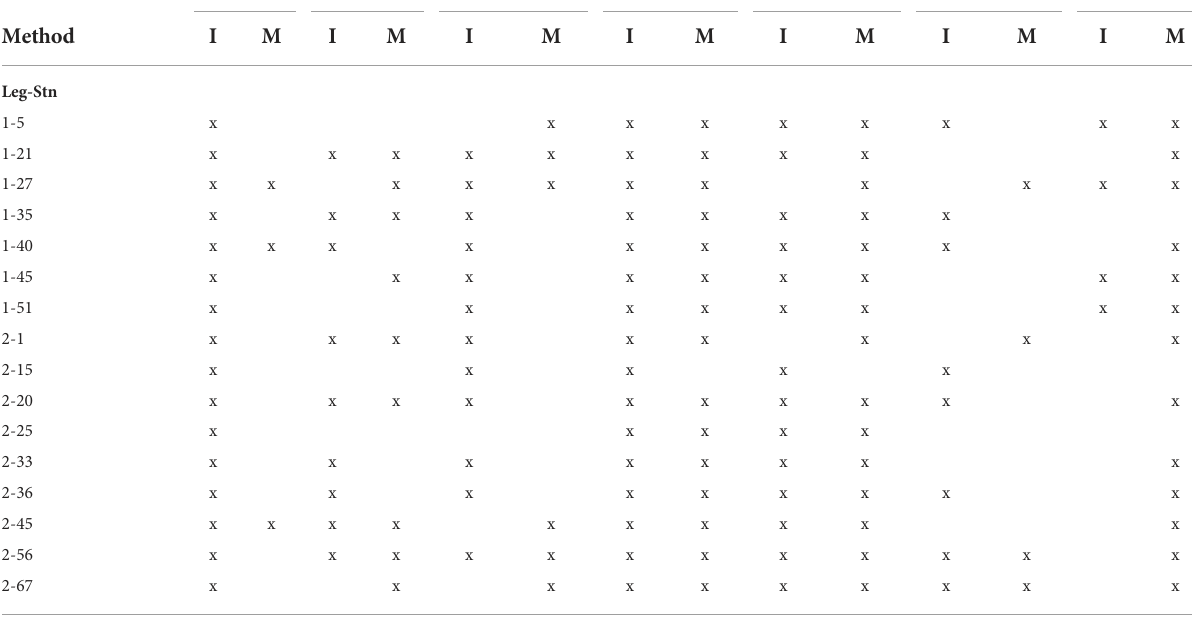
TABLE 3 The presence and absence of the different taxonomic groups for the entire size spectra studied using imaging (I) and metabarcoding (M) methods. Taxonomic groups Nassellaria Spumellaria Challengeridare Aulacanthidae Coelodendridae